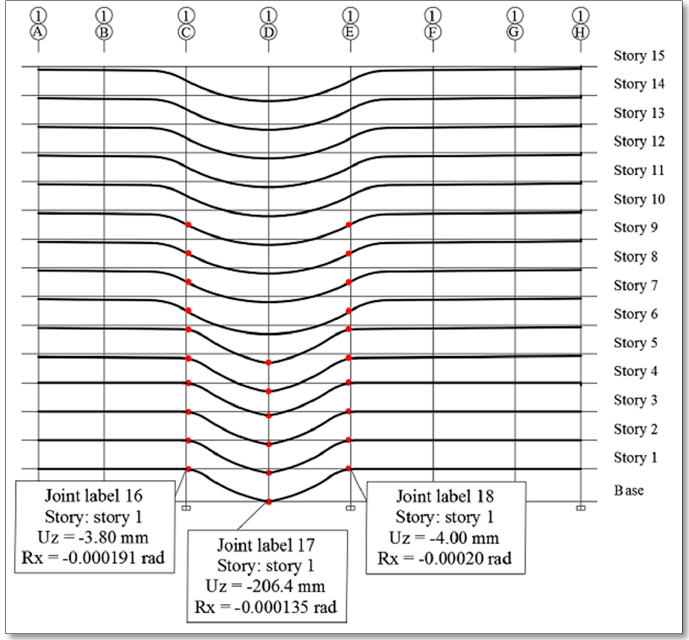
Figure 16. Displacement at the location of notionally removed column D1 when moment frames are located at perimeters only (non-linear dynamic analysis case 13).